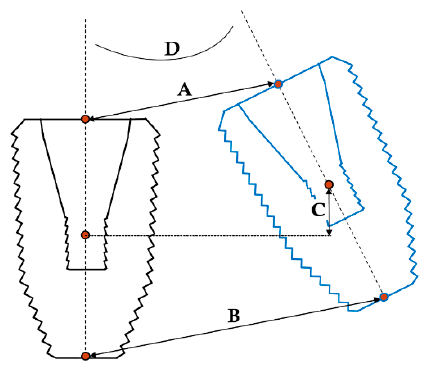
Figure 5. Discrepancy parameters between the estimated and actual 3D positions of implant. A: Linear deviation at the platform; B: linear deviation at the bottom; C: vertical deviation; D: angular deviation.